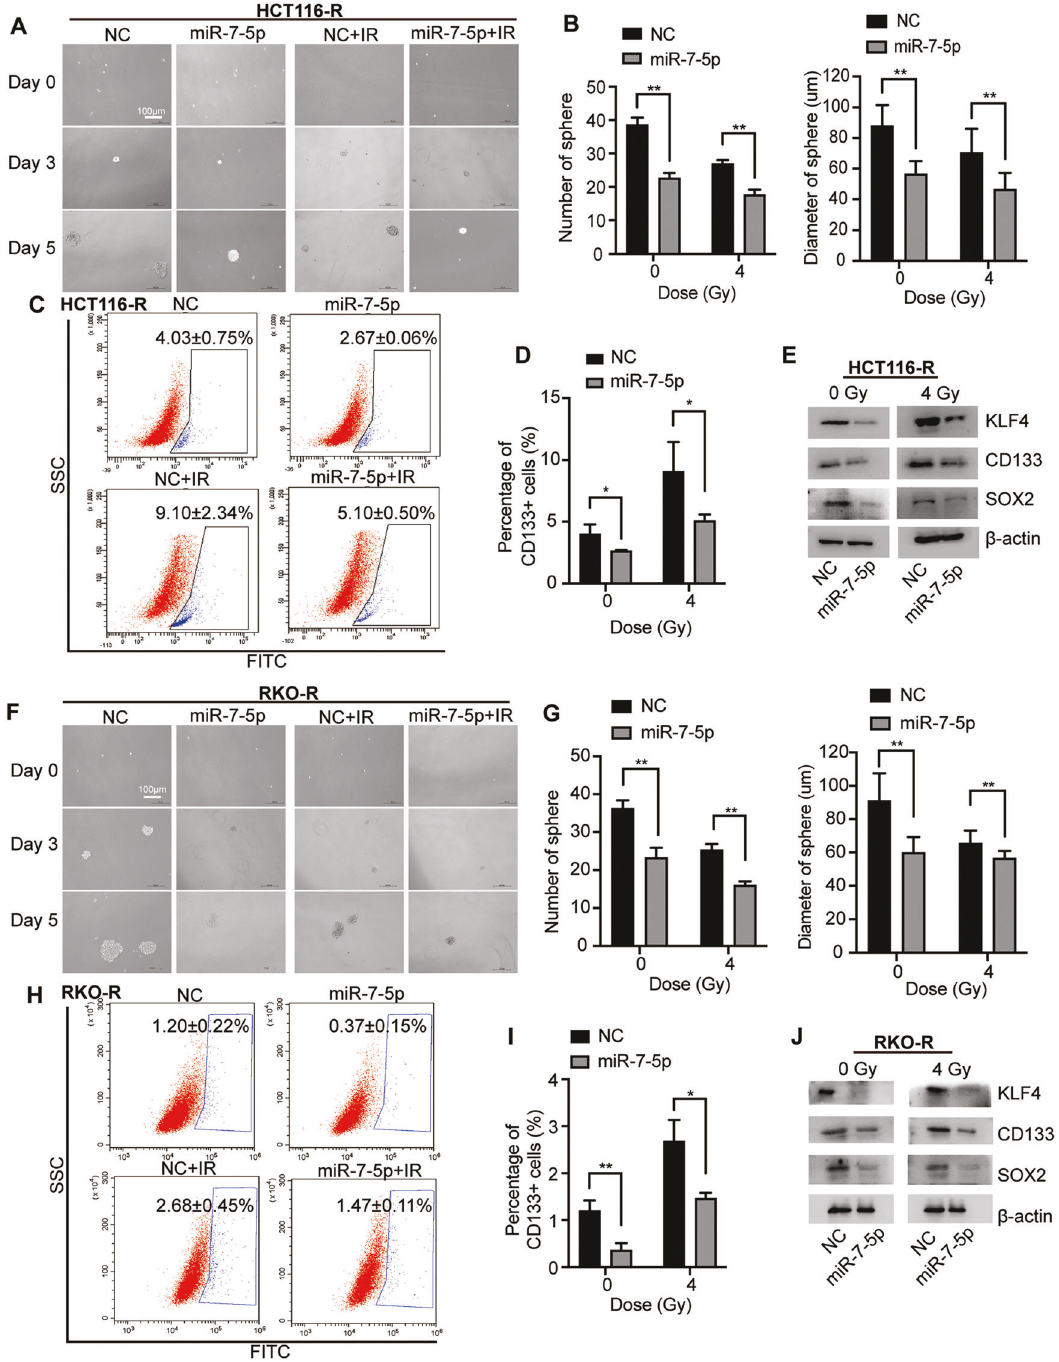
Fig. 3 MiR-7-5p suppressed cancer cell stemness in CRC cells. A Sphere formation assays using HCT116-R cells after overexpression of miR-7- 5p w/wo 4 Gy irradiation treatment. B Quantitative analysis of A showed that overexpression of miR-7-5p reduced the sphere number and diameter in HCT116-R cells w/wo 4 Gy irradiation treatment. C miR-7-5p overexpression in HCT116-R decreased the CD133 + CSC subpopulation under irradiation of 0 or 4 Gy. D Quantitative analysis of C . E Gene expression analyses showed negative regulation of stemness genes including KLF4, CD133 and SOX2 at the protein levels by miR-7-5p overexpression in HCT116-R cells. F Sphere formation assays using RKO-R cells after overexpression of miR-7-5p w/wo 4 Gy irradiation treatment. G Quantitative analysis of (F) showed that overexpression of miR-7-5p decreased the sphere number and diameter in RKO-R cells. H miR-7-5p overexpression in RKO-R cells decreased the CD133 + CSC subpopulation under irradiation of 0 and 4 Gy. I Quantitative analysis of H. J. Gene expression analyses showed negative regulation of stemness genes including KLF4, CD133 and SOX2 at the protein levels by miR-7-5p overexpression in RKO-R cells. Data are presented as mean ± SD; w/wo, with or without; IR, irradiation (4 Gy); * P < 0.05; ** P < 0.01.